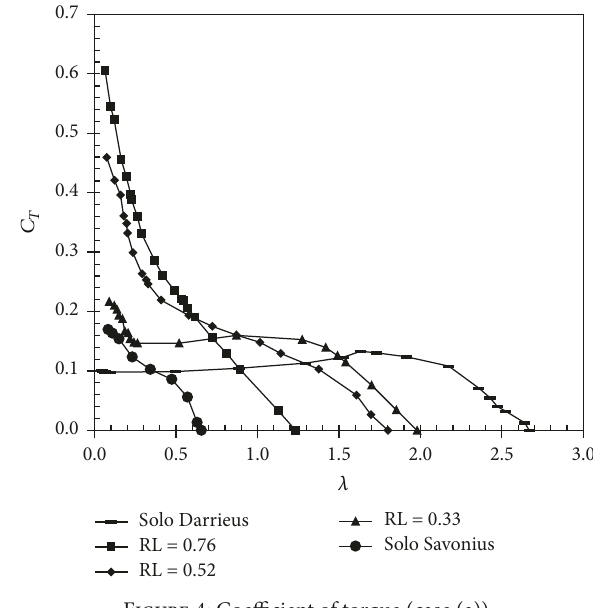
Figure 4: Coefficient of torque (case (a)).